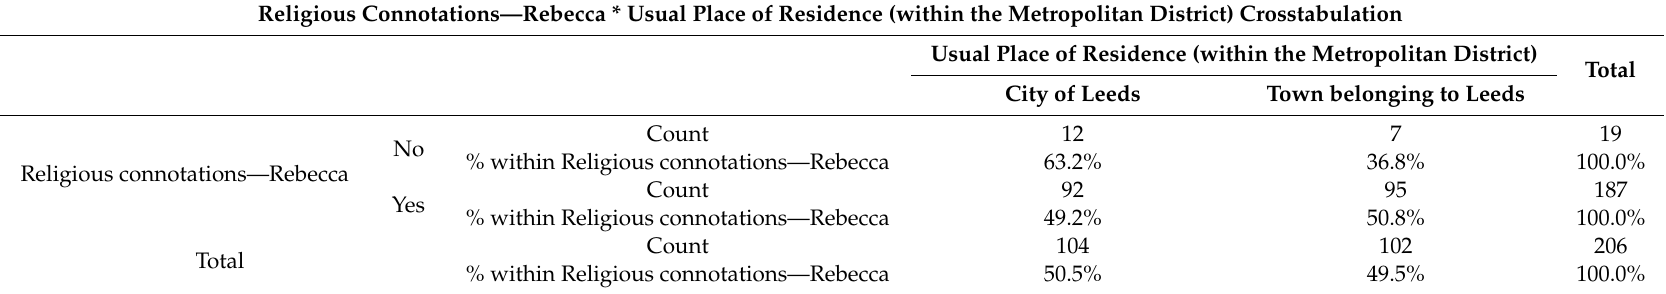
Table 13. Religious connotations in terms of usual place of residence for the name Rebecca in the metropolitan district of Murcia. Religious Connotations—Rebecca * Usual Place of Residence (within the Metropolitan District)